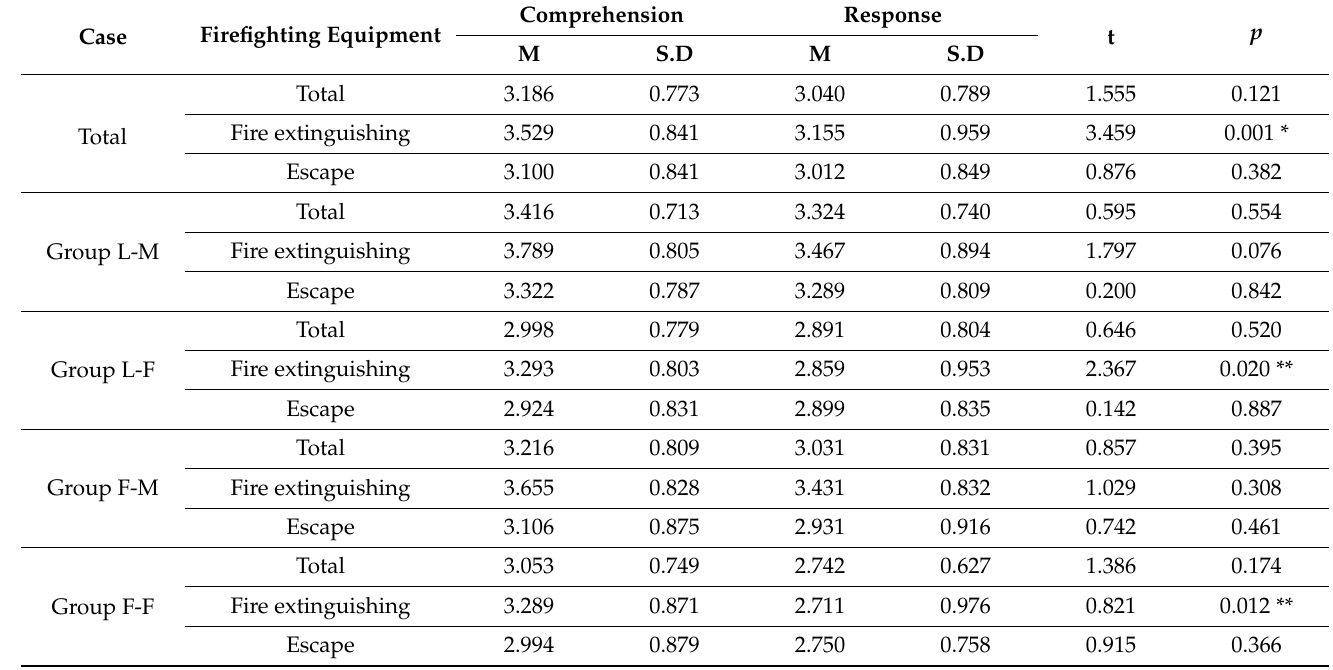
Table 7. Difference between Comprehension and Response scores depending on the types of firefight- ing equipment by group ( t -test